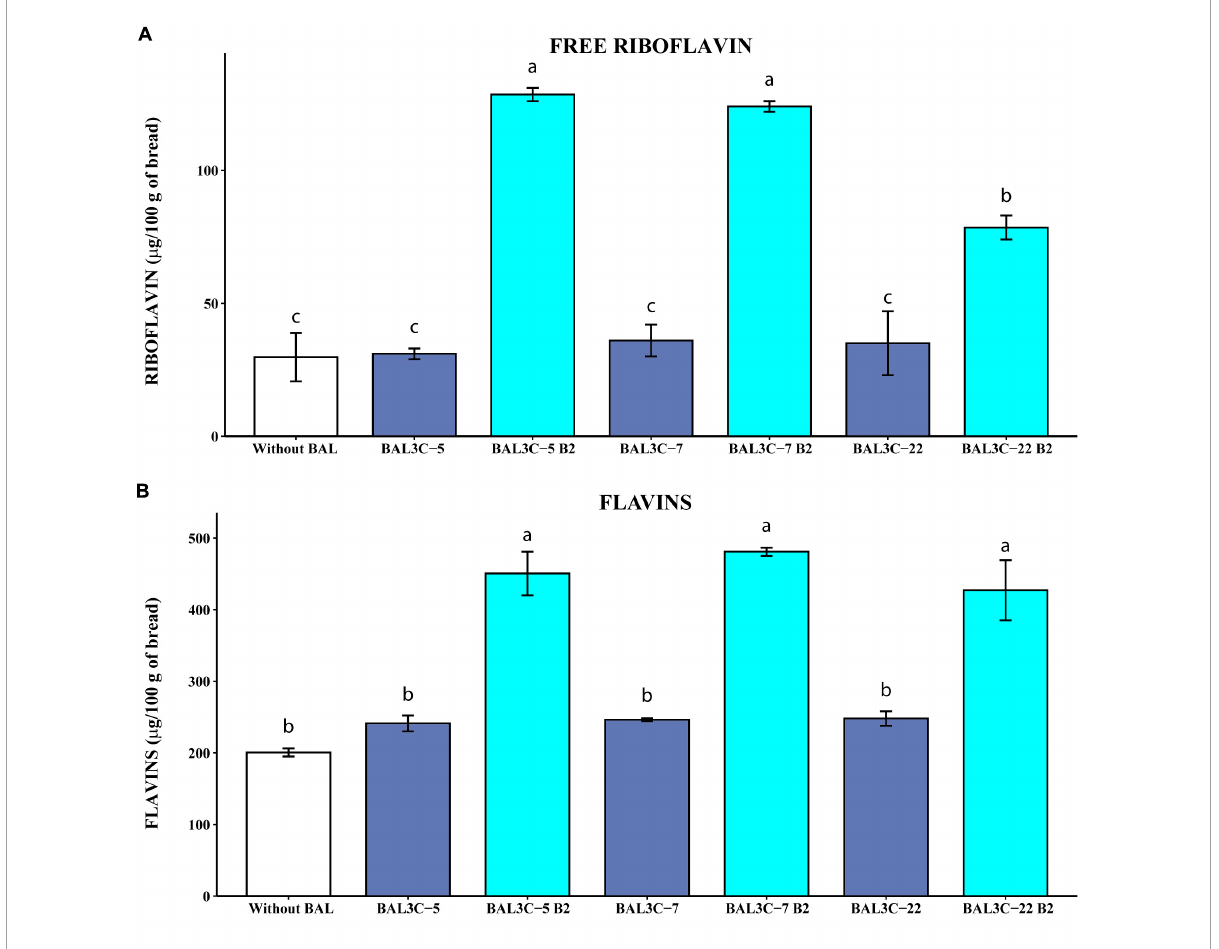
FIGURE5 Determination of the free riboflavin and the flavin levels in breads produced with Weissella cibaria strains. Levels of water-soluble riboflavin (free riboflavin) (A) or riboflavin generated by acidic hydrolysis at high temperature of flavins (flavins) (B) present in the breads are depicted. The means of two determinations and the standard deviations are indicated. Values with different superscript letters indicate that the levels differed significantly ( p ≤ 0.05, see details of statistical analysis in Supplementary Figure 6 ).